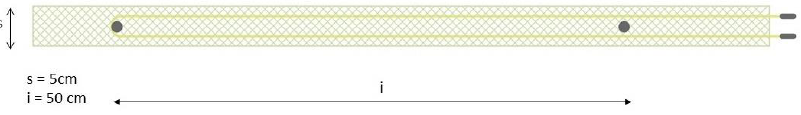
Figure 3. Transducer top view.